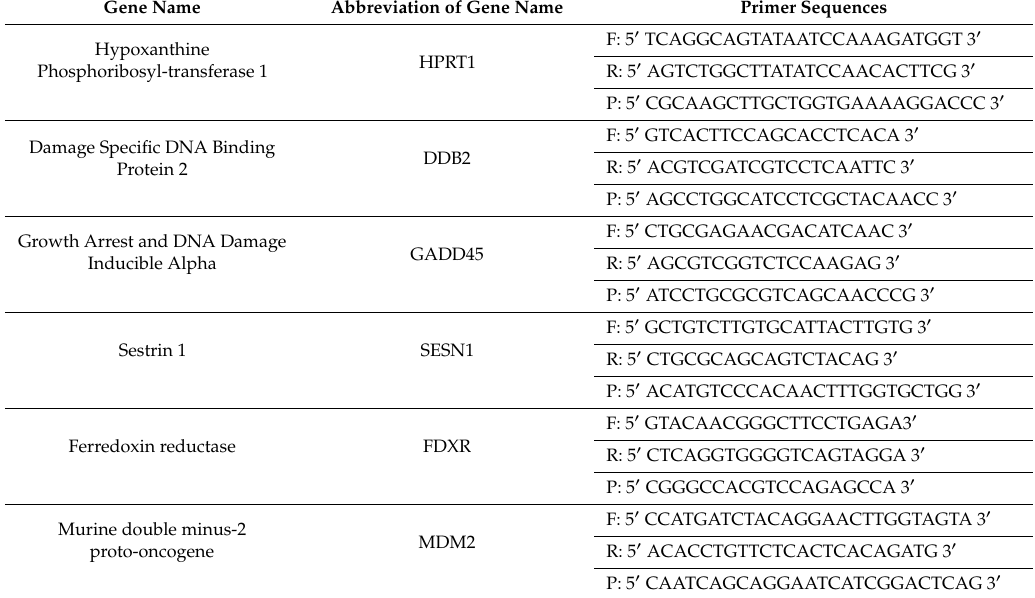
◦ Table 3. The reactions were performed with the following cycling conditions: 2 min at 95 C, then 45 ◦ ◦ cycles of 10 s at 95 C and 60 s at 60 C. Data were collected and analyzed by Rotor-Gene Q Series Software. Gene target Ct (cycle threshold) values were normalized to HPRT1 internal control. Ct values were converted to transcript quantity using standard curves obtained by serial dilution of PCR-amplified DNA fragments of each gene. The linear dynamic range of the standard curves covering − 4 − 10 six orders of magnitude (serial dilution from 3.2 × 10 to 8.2 × 10 ) gave PCR e ffi ciencies between 93 and 103% for each gene with R 2 > 0.998. Table 3. The investigated genes and the list of primer sequences used for the